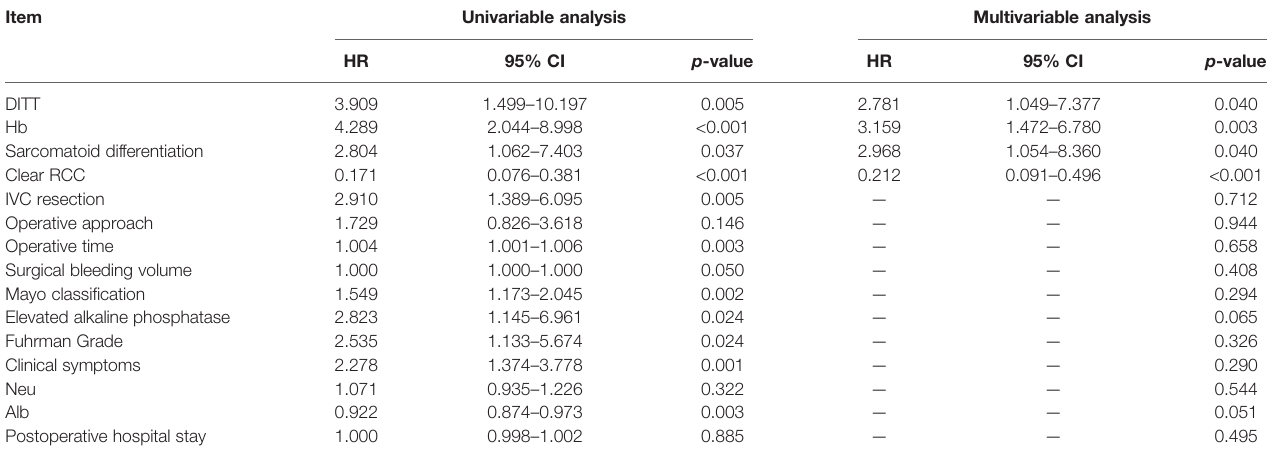
TABLE 2 | Univariate and multivariate Cox regression analysis of renal cancer combined with tumor thrombus. Item